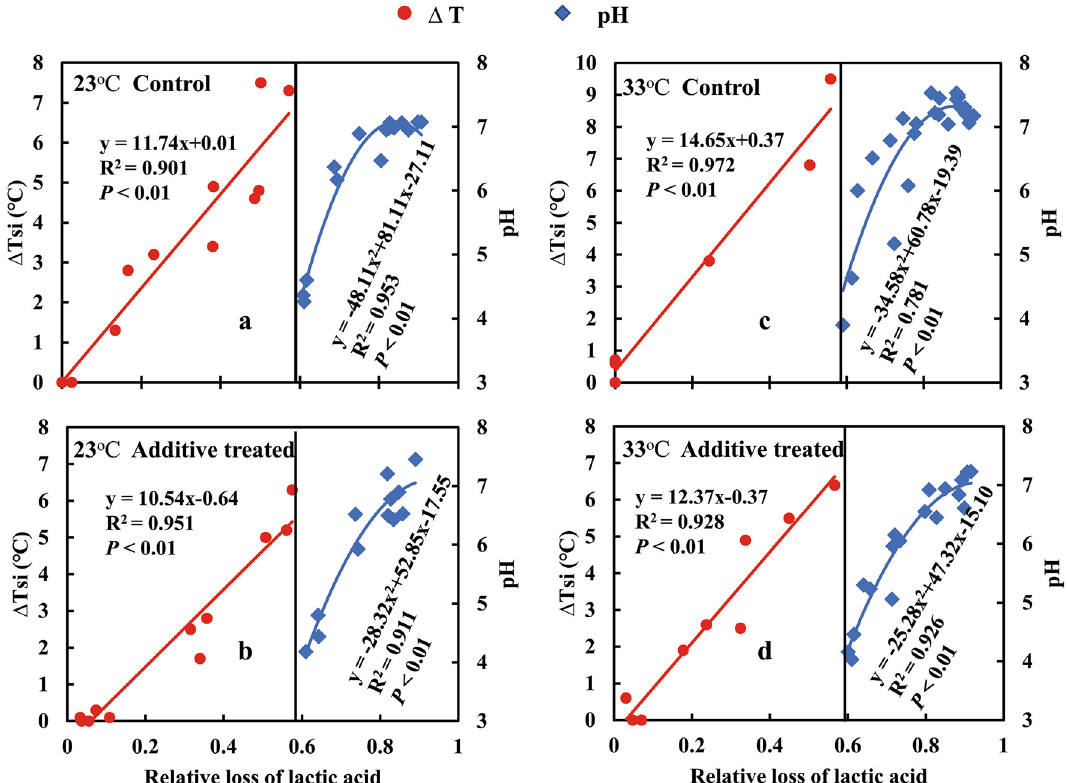
Figure 5. Estimates of the relative loss of lactic acid (RLLA) in the control silage ( a , c ) and biological additive- treated silage ( b , d ) at 23 °C ( a , b ) and at 33 °C ( c , d ) using T si and